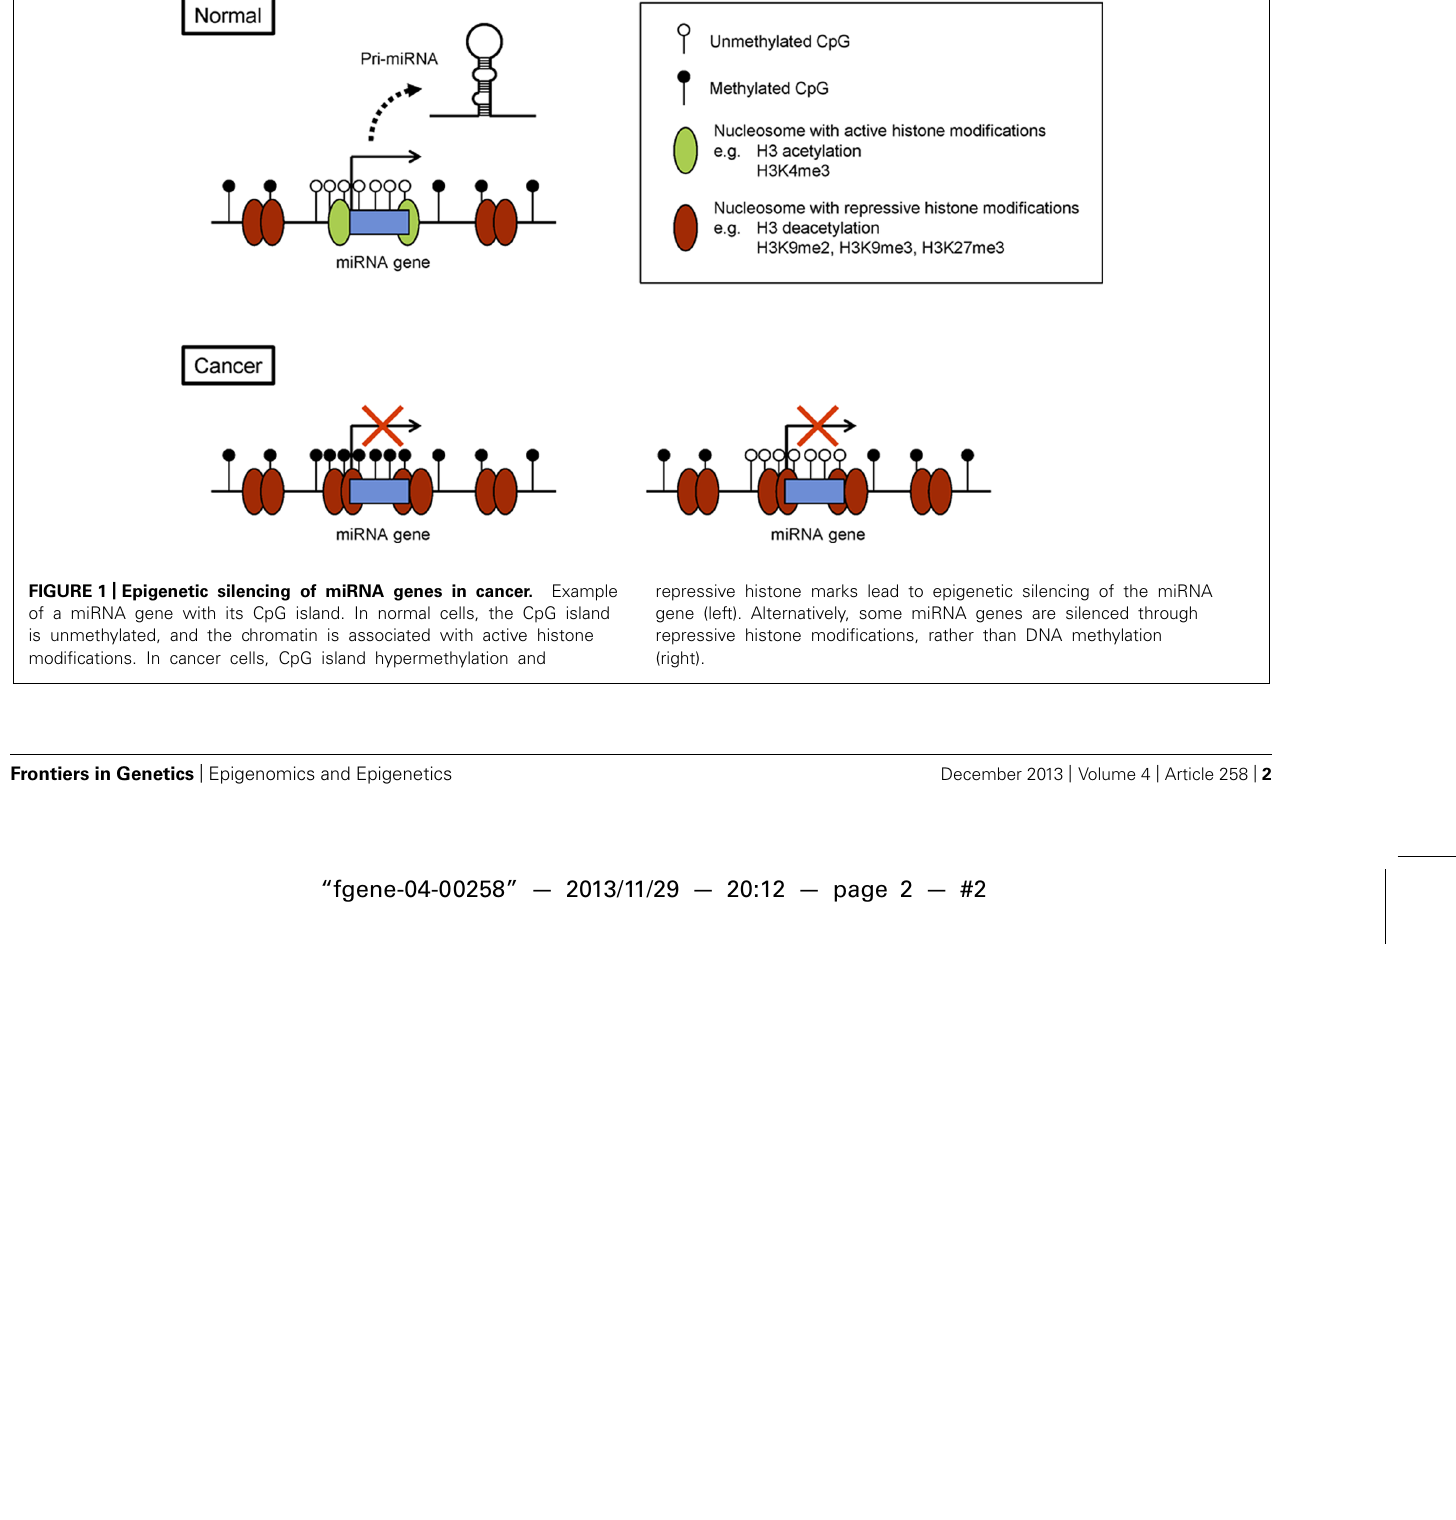
repressive histone marks lead to epigenetic silencing of the miRNA gene (left). Alternatively, some miRNA genes are silenced through repressive histone modifications, rather than DNA methylation